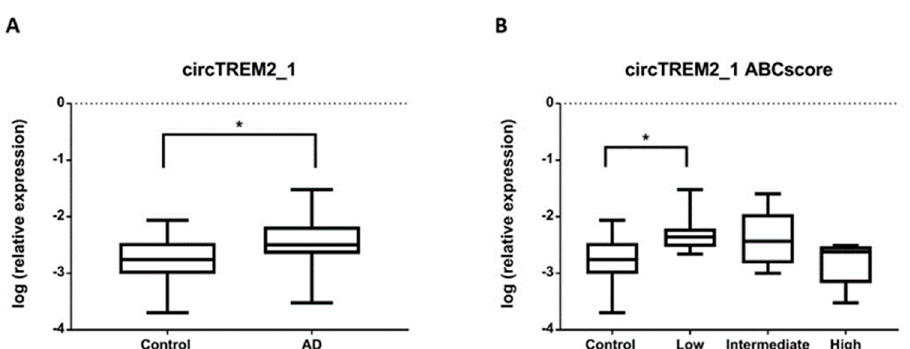
Figure 2. circTREM2_1 expression levels relative to ACTB housekeeping gene expression. ( A ) The graph shows a significant increase in circTREM2_1 levels in AD entorhinal cortex samples compared to control entorhinal cortex samples. ( B ) circTREM2_1 expression decreased across AD stages, as shown when circTREM2_1 expression levels are sorted by ABC score. Vertical lines represent the standard error of the mean. * p -value <